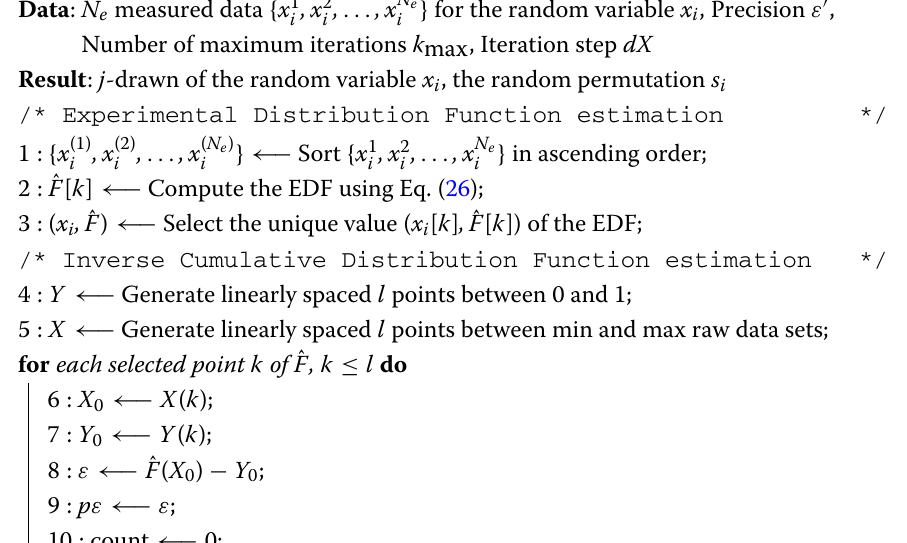
Algorithm 1: Pre-processing module - Data driven random